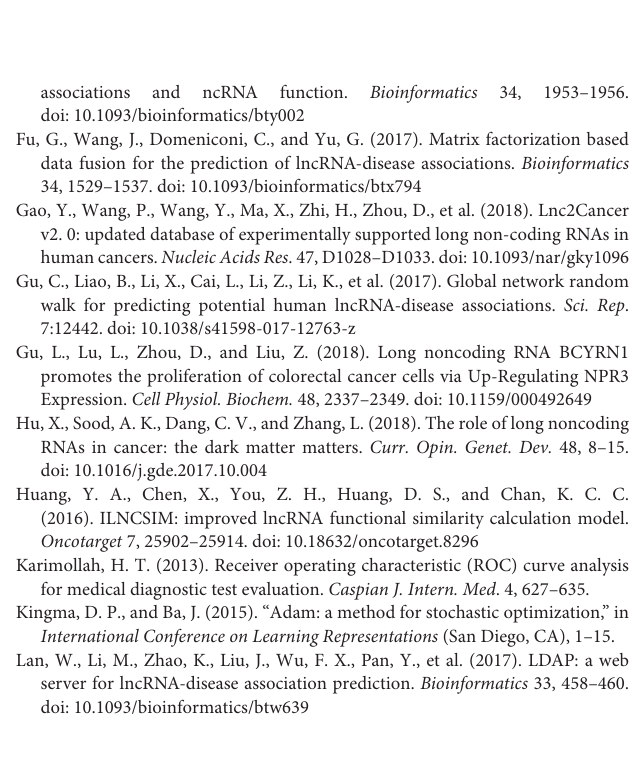
Supplementary Table 1 | Potential candidate lncRNAs related to 402 diseases. Supplementary Table 2 | The lncRNA